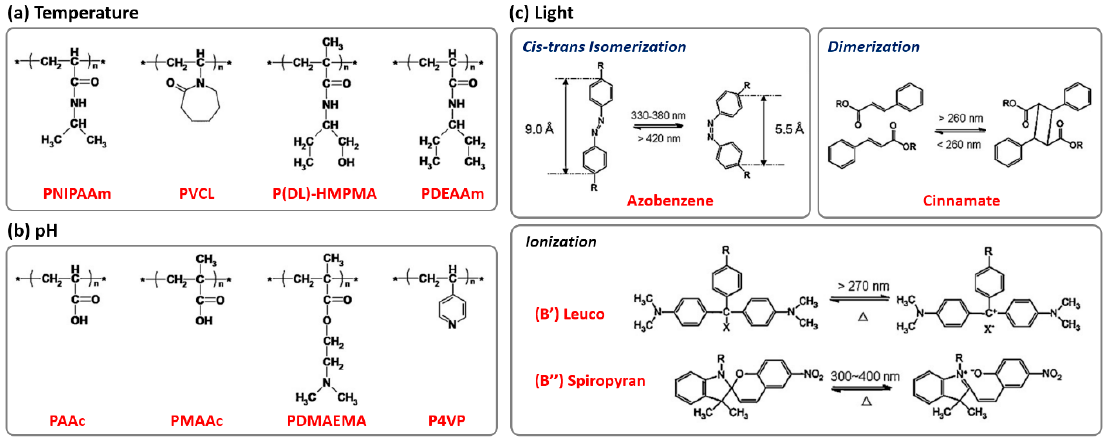
Figure 3. Examples of molecular structures responsive to ( a ) temperature, ( b ) pH, and ( c ) light (reprinted with permission from [59], Copyright 2010, Elsevier).